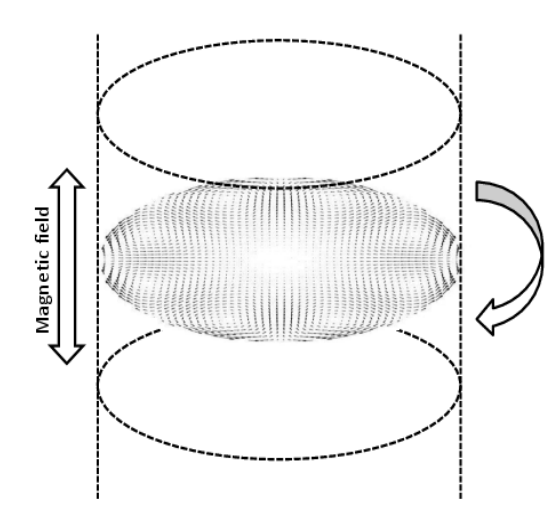
Figure 1. Electric field displacement for a wave circulating in a cylinder as indicated by the arrow. The magnetic field oscillates in the (vertical) direction of the z